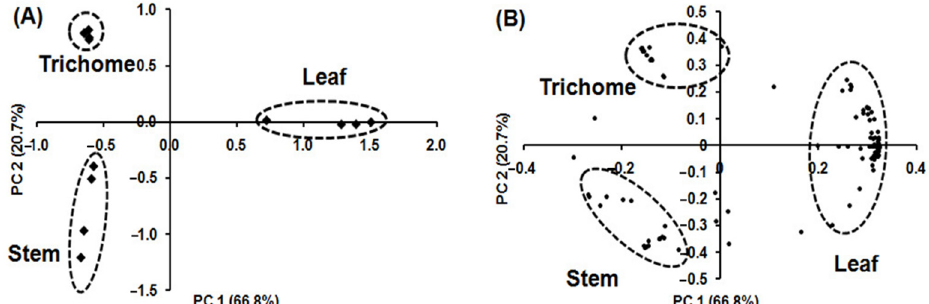
Figure 5. PCA biplot of volatile metabolites originating from glandular trichomes isolated from stems, trichome-free stems, and leaves of alfalfa plants on the basis of 133 volatile metabolites ( n = 4); ( A ) score plot showing separation of glandular trichomes, stems, and leaves tissue; ( B ) loading plot showing distribution of 133 volatile metabolites. The score plot illustrates clear differentiation between the volatile metabolic profiles of glandular trichomes, stems, and leaves and the loading plot indicates the contributions of independent volatile metabolites on the separations in the PCA score plot.